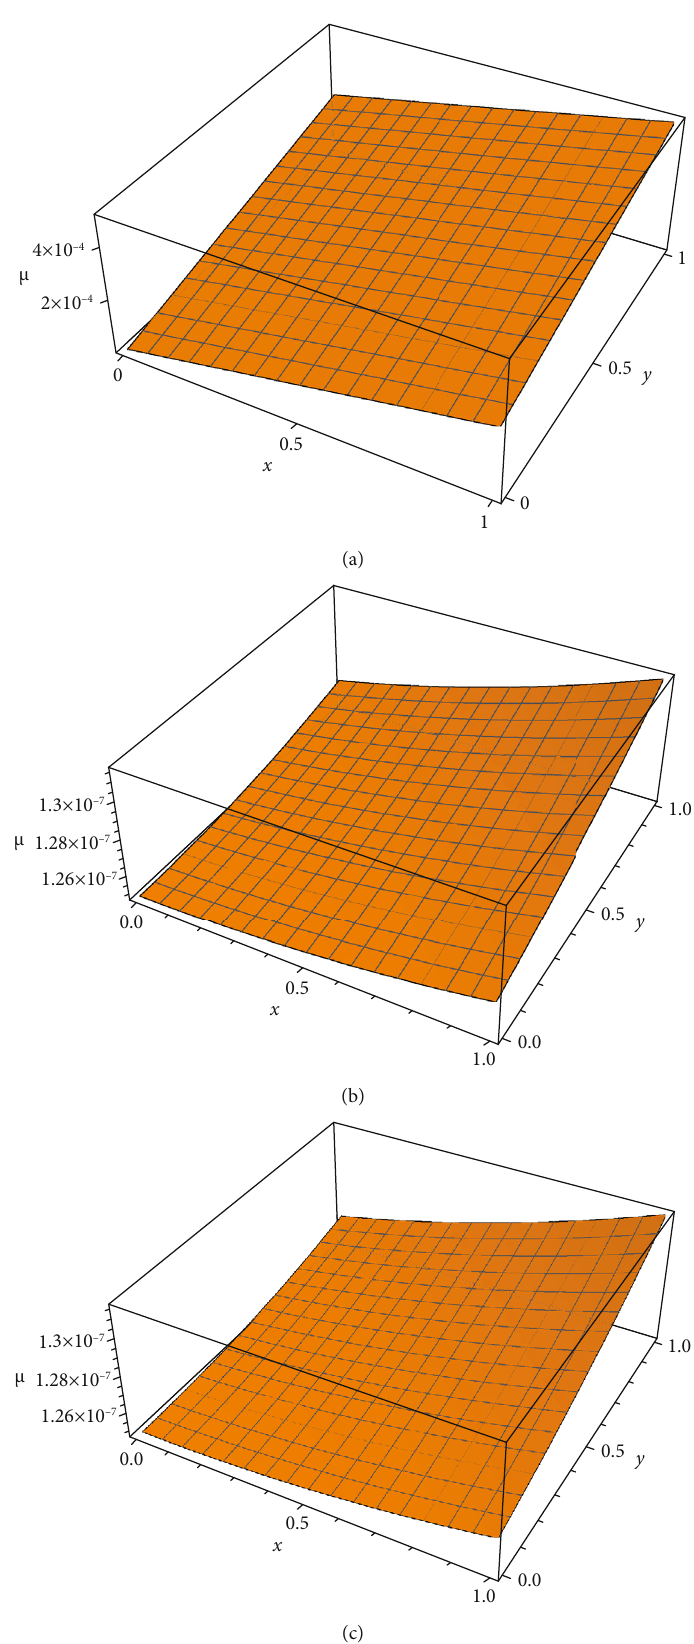
Figure 4: (a) Exact solution, (b) absolute error of NTDM